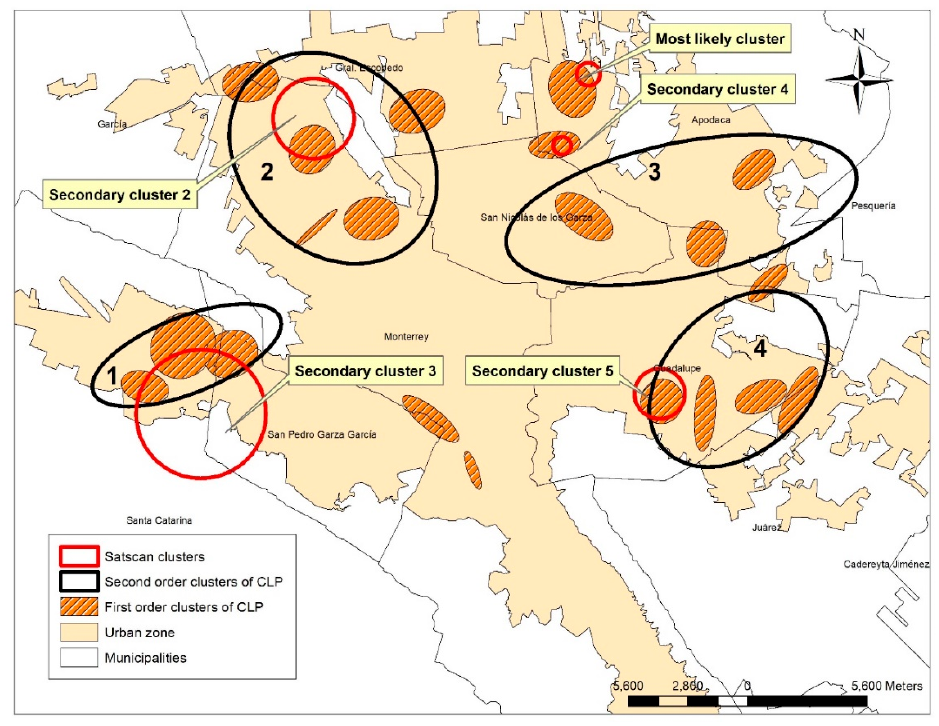
Figure 9. Cluster localization by SaTScan.